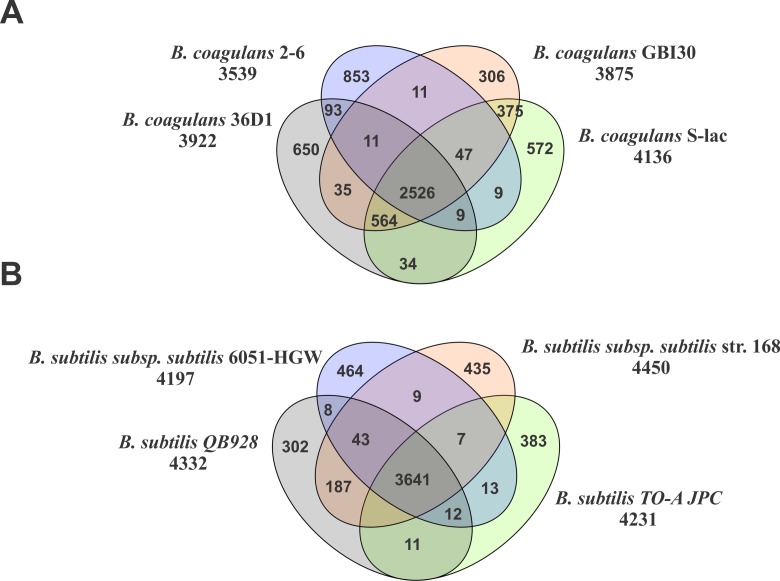
Core, dispensable and unique sets of proteins a) Orthologous set of proteins in Bacillus coagulans S-lac, Bacillus coagulans GBI-30, Bacillus coagulans 36D1 and Bacillus coagulans 2–6 b) Orthologous set of proteins in Bacillus subtilis TO-A JPC, Bacillus subtilis subsp. subtilis str. 168, Bacillus subtilis subsp. subtilis 6051-HGW and Bacillus subtilis QB928.